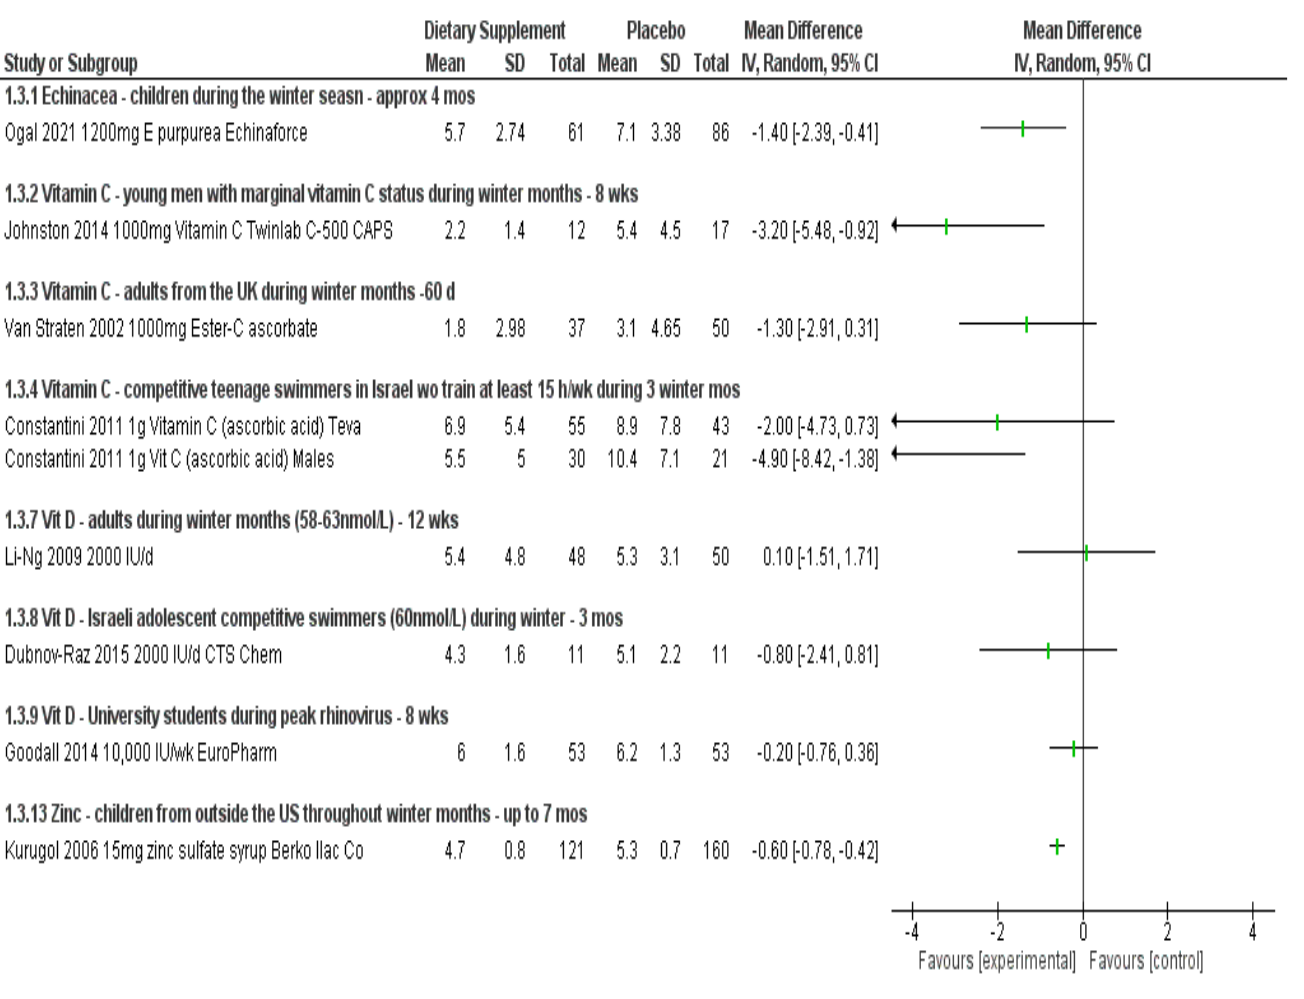
Figure 3. Analysis 1.3 Duration of symptoms per event experienced by participants.